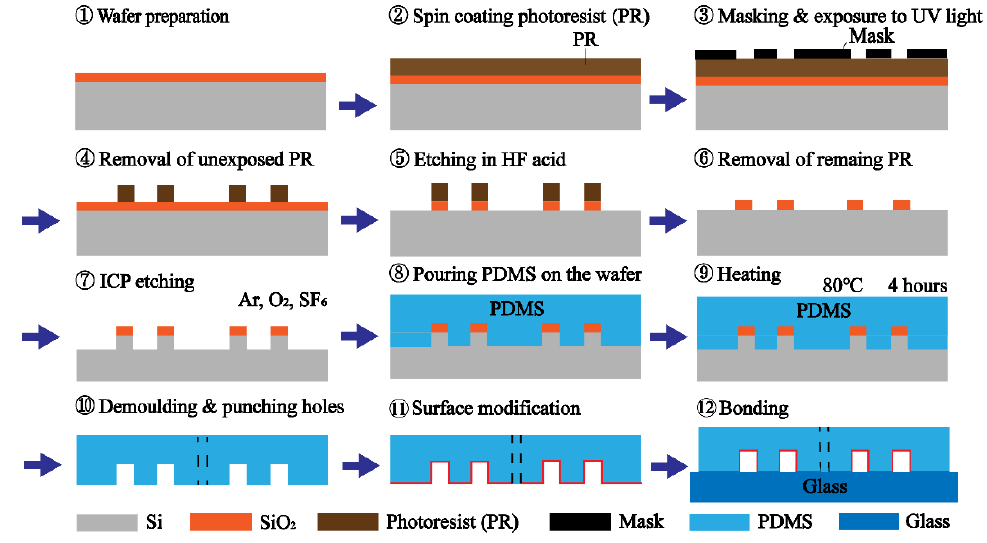
Figure 2. Fabrication procedure of the cell-trapping microfluidic chip.